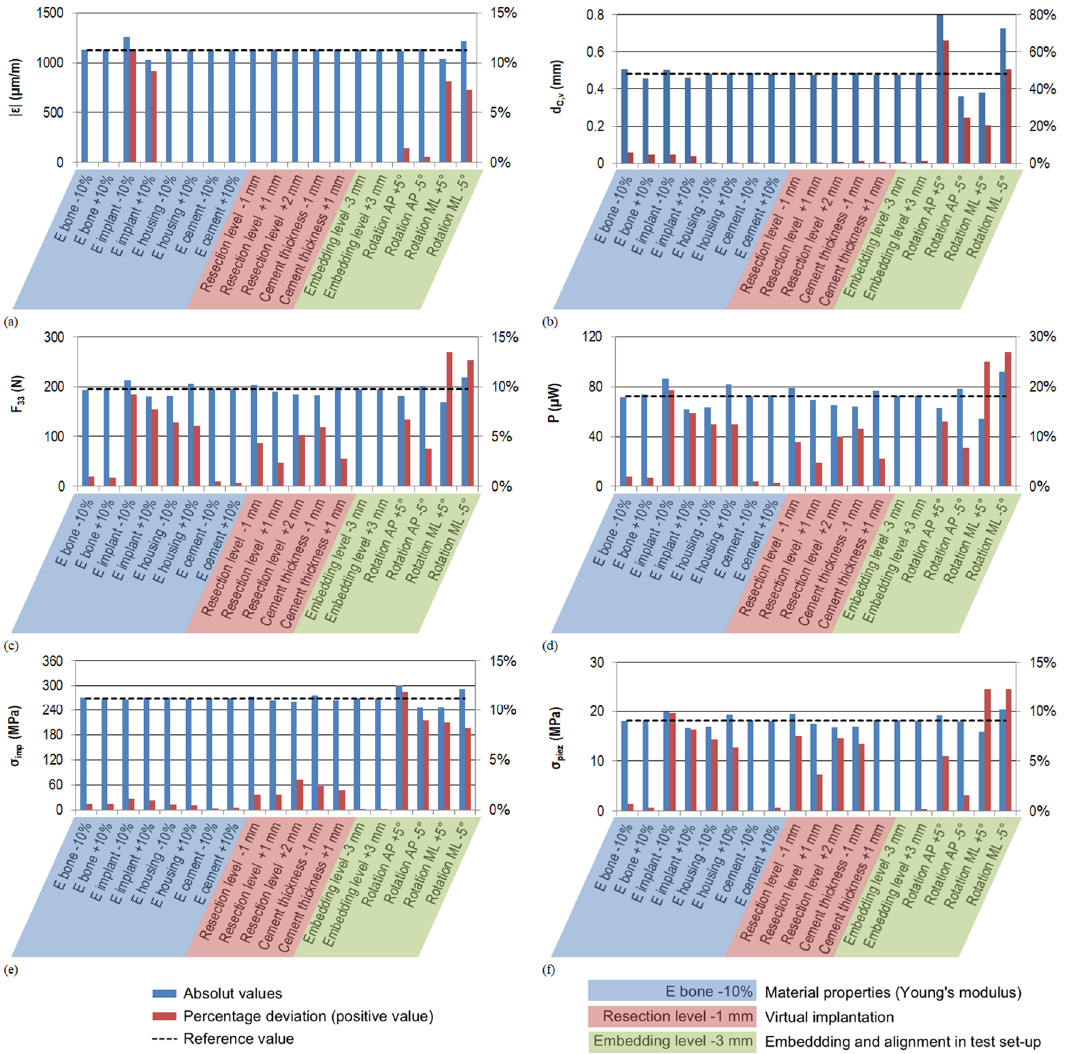
Figure A1. Results of the sensitivity analysis (absolute values in blue and percent deviation in red). The dashed line represents the original value of the reference model. For convenience, the absolute values of the percentages are shown. ( a ) Simulated strain for the strain gauge ε SG ( µ m/m); ( b ) displacement of point C in vertical direction of the uniaxial testing machine (direction of the acting force) d C,v (mm); ( c ) contact force F 33 acting on the piezoelectric element’s end faces in the direction of its cylinder axis (N); ( d ) generated power calculated from F 33 ( µ W); ( e ) maximum von Mises stress in the implant cavity σ imp (MPa); and ( f ) maximum von Mises stress in the piezoelectric element mid plane cross-section σ piez (MPa). (Abbreviations: E—Young’s modulus; AP—antero-posterior; ML—medio-lateral).